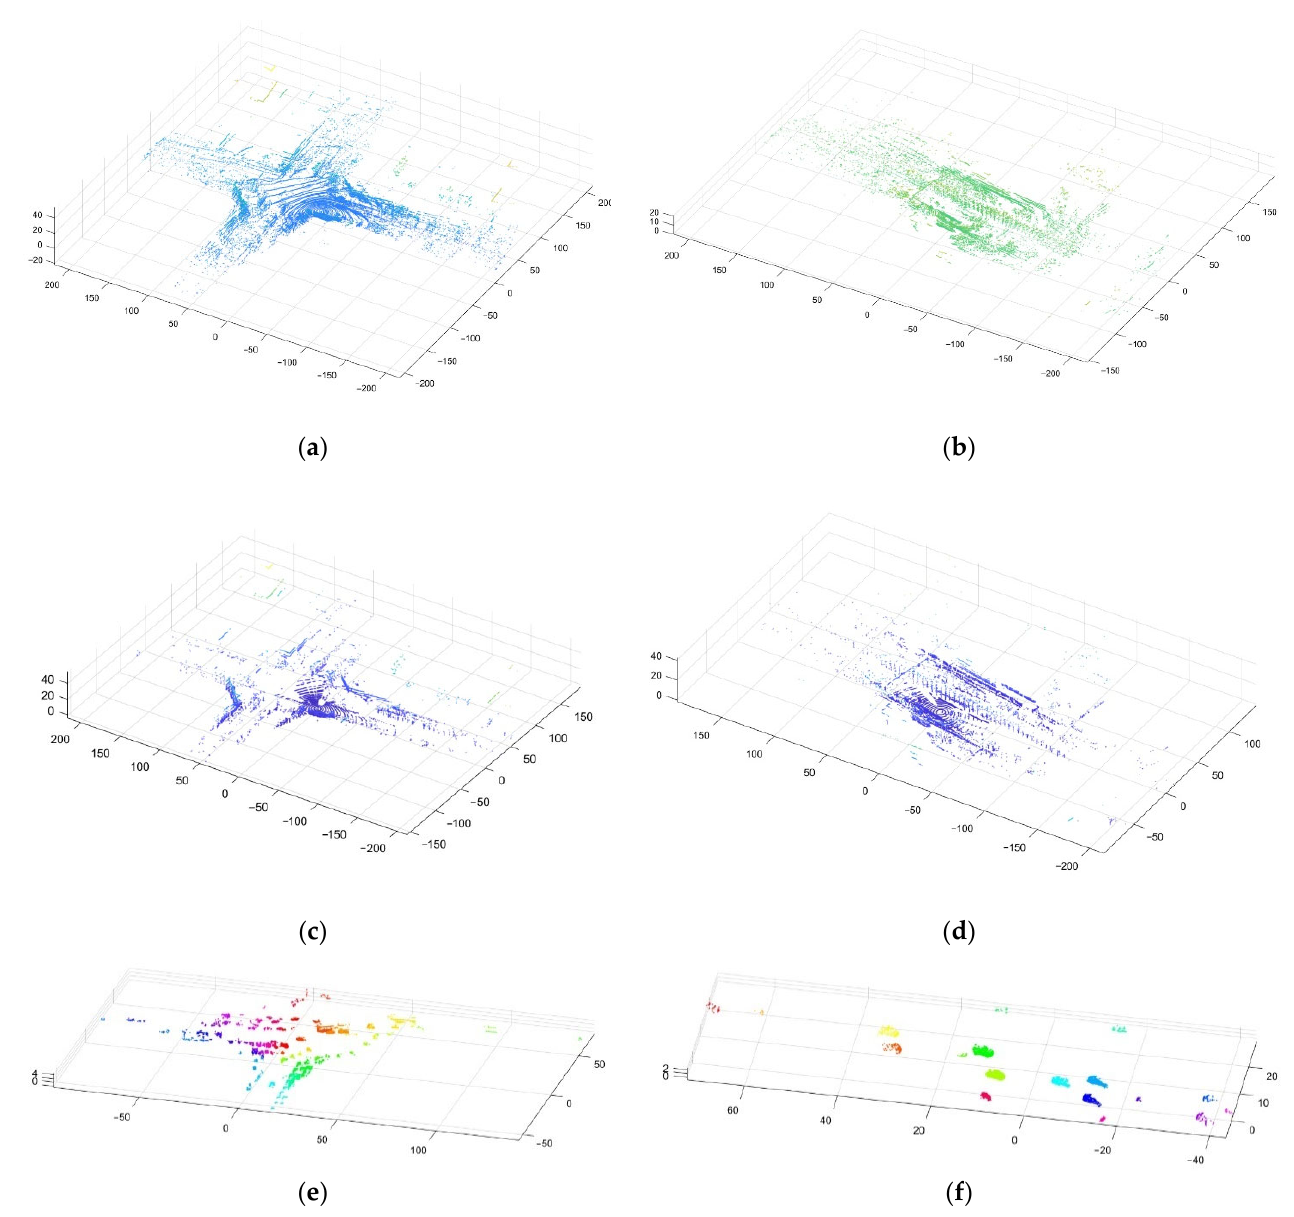
Figure 14. The polar grids established in the two scenes. ( a ) The visualized polar grid of the urban intersection scene. ( b ) The visualized polar grid of the urban road scene. ( c ) The background point clouds of the urban intersection scene. ( d ) The background point clouds of the urban road scene. ( e ) The target clustering result of the urban intersection scene. ( f ) The target clustering result of the urban road scene.